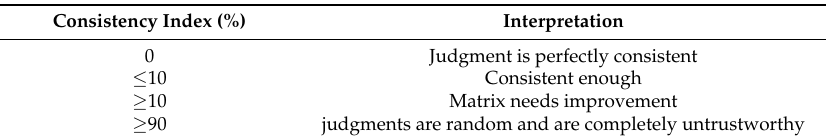
Table 4. Consistency index